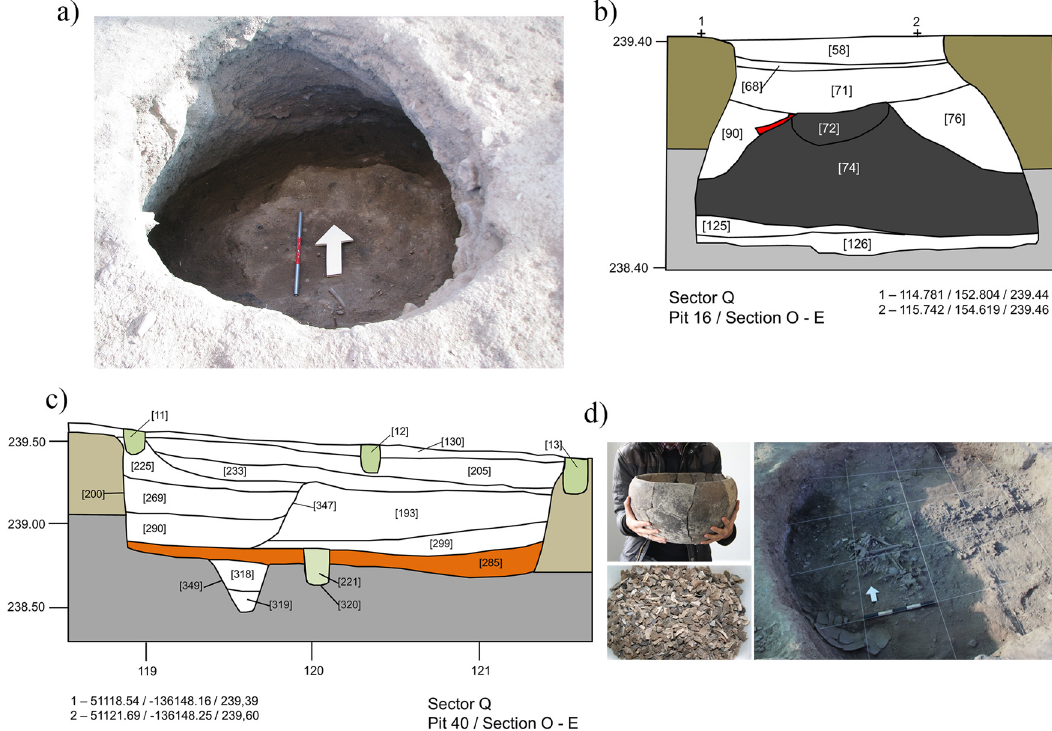
Figure 2: Detail of the conic - shaped deposit containing cremations in pit 16 ( a ) ; pro fi le of pit 16 ( b ) ; aspect of the human cremated remains in pit 40 ( c ) ; pro fi le of pit 40 ( d ) ( after Valera, 2020 )